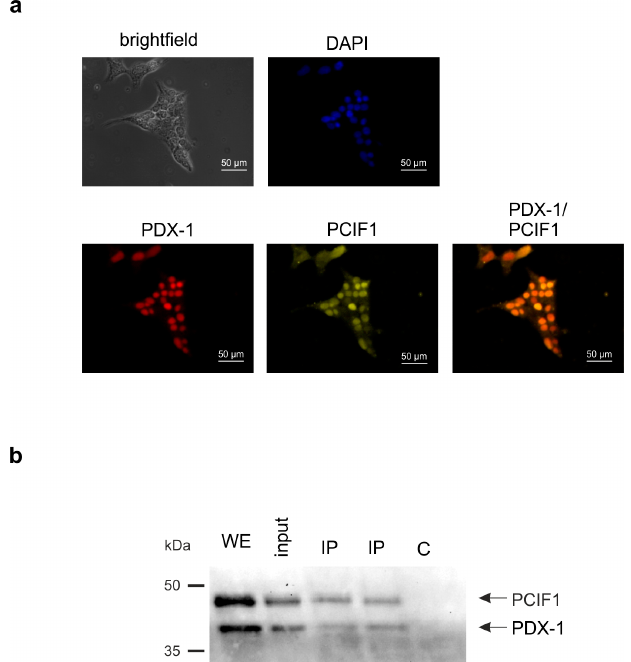
Figure 1. PDX-1 and PCIF1 interaction in MIN6 cells. ( a ) Immunofluorescence analysis of endogenous PDX-1 and PCIF1. MIN6 cells were cultured on coverslips and stained with a polyclonal rabbit antiserum against PDX-1, a goat polyclonal antiserum against PCIF1 (SPOP K-13) and DAPI for nuclei staining. As secondary antibodies, ALEXA-Fluor TM 488 or ALEXA-Fluor TM 594 were used. Immunofluorescence was analyzed using a Zeiss Axioskop fluorescence microscope (Zeiss, Jena, Germany). Magnification: 400 × ; and ( b ) co-immunoprecipitation of PDX-1 and PCIF1 from transfected MIN6 cell extracts. MIN6 cells were transfected with PDX-1 and FLAG-tagged PCIF1 for 24 h. Two mg of cell extract were precleared twice with a mixture of protein A sepharose beads and CL 4-B agarose beads over a period of 1 h. The supernatants were incubated with a rabbit PDX-1 antibody for 2 h. The immunoprecipitated proteins were separated by 12.5% SDS polyacrylamide gel electrophoresis, transferred to a polyvinylidenfluoride (PVDF) membrane and analyzed by Western blot with the mouse monoclonal M2 antibody against the FLAG-tag of PCIF1 and the polyclonal rabbit antiserum against PDX-1. WE: whole cell extract (20 µ g), input: 10% of cell extracts used for immunoprecipitation, C: control without antibody, IP: immunoprecipitate, two independent precipitations.